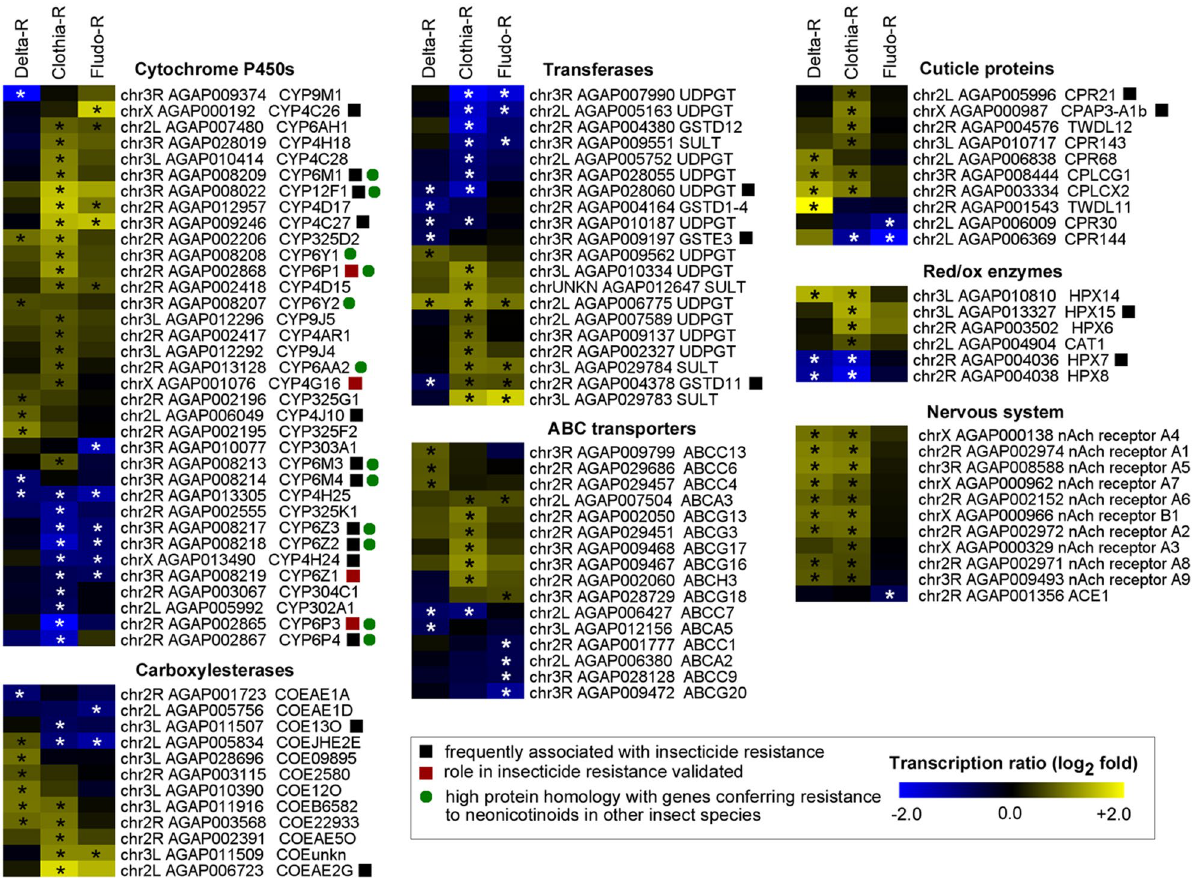
Figure 4. Transcription profiles of candidate genes associated with resistance. All candidate genes differentially transcribed in at least one selected line are shown. Colour scale shows the mean Log 2 Fold Change between each selected line and the parental Tiassalé-S line. Stars indicate a significant differential transcription (FC > 1.5- fold and corrected P value ≤ 0.005). Black squares indicate genes frequently associated insecticide resistance. Red squares indicate functionally validated resistance genes. Green dots indicate genes showing high protein homology with genes conferring resistance to neonicotinoids in other insect